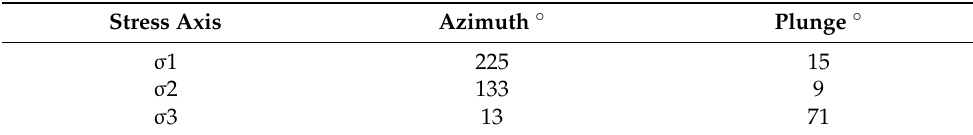
Table 7. Principal stress